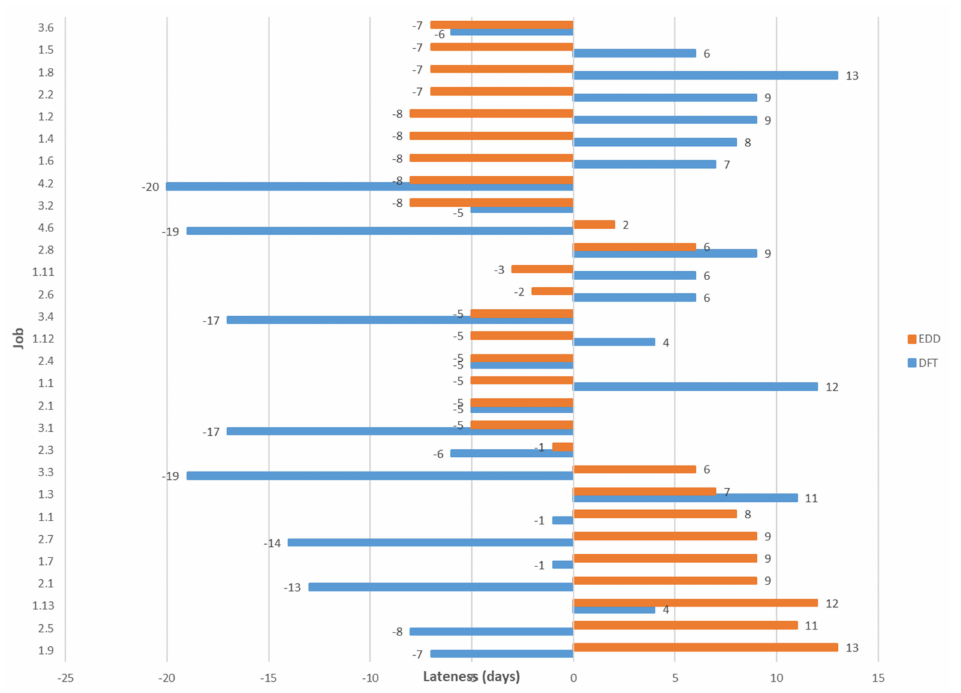
Figure 8. Lateness of orders resulting from EDD and DFT